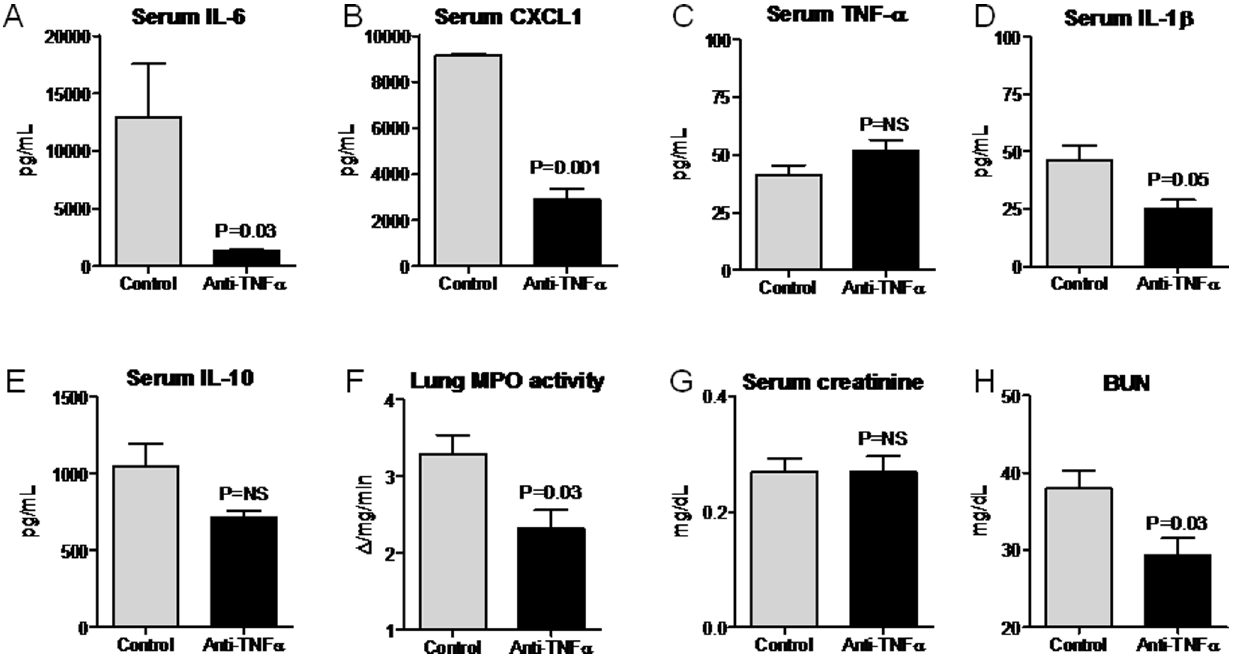
Figure 8. Serum cytokines, lung MPO activity, serum creatinine, and BUN in mice treated with anti-TNF- a therapy 2 hours before intraperitoneal (IP) endotoxin administration. Serum (A) IL-6, (B) CXCL1, (C) TNF- a , (D) IL-1 b , (E) IL-10, and (F) lung MPO activity, and (G) serum creatinine, and (H) BUN were determined 4 hours after IP endotoxin in mice treated with anti-TNF- a antibody (Anti-TNF- a ) or control 2 hours before endotoxin administration; n=4–5. The serum proinflammatory cytokines IL-6, CXCL1, and IL-1 b , lung MPO activity and BUN were all reduced by pre- treatment with anti-TNF- a antibody.